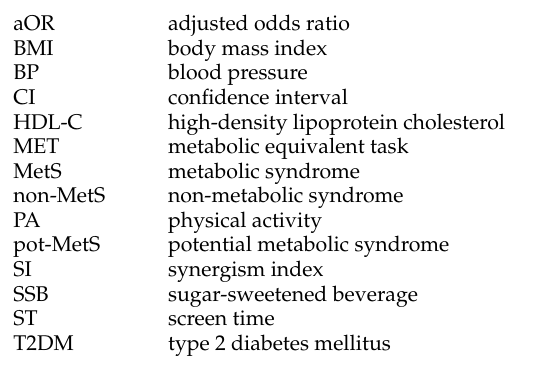
Table S1: Combined and interaction effects of adolescents’ lifestyle factors on potential metabolic syndrome and metabolic syndrome. Figure S1: Distribution of overweight and obesity among adolescents with non-metabolic syndrome (non-MetS), potential metabolic syndrome (pot-MetS) and metabolic syndrome